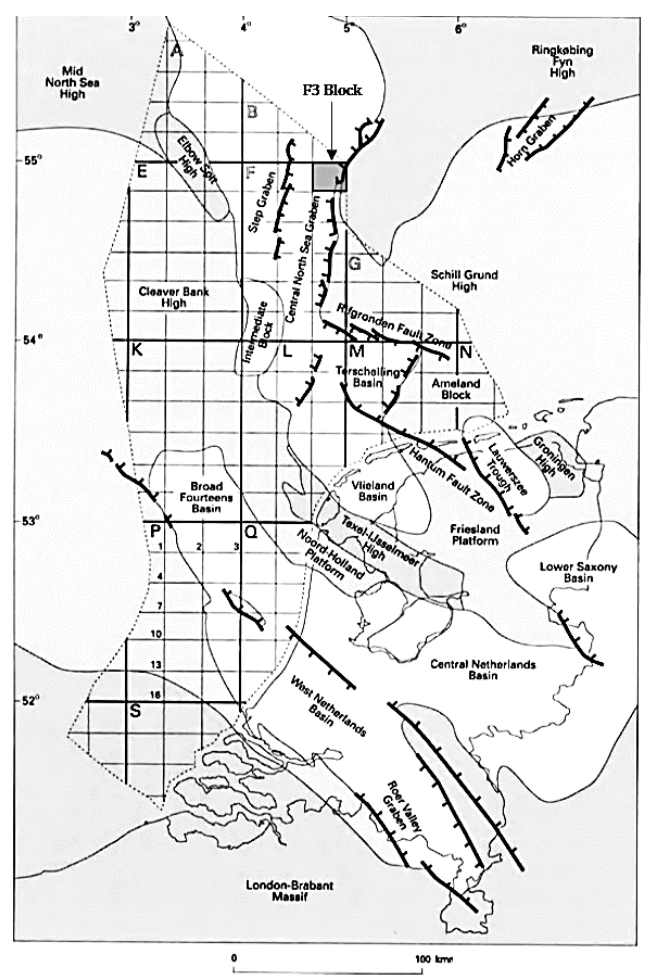
Figure 1. The location map of the F3 block, the study area (rectangle is indicated by arrow). It is located in the Dutch sector of the North Sea. After Remmelts [35].